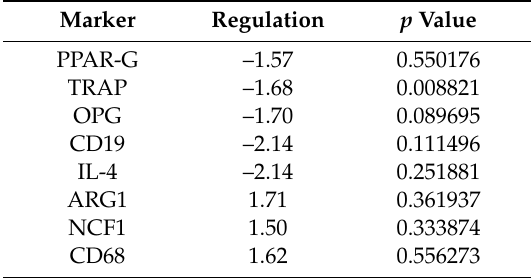
Table 4. Gene expression analysis of PEEK compared to Ti (10 days).